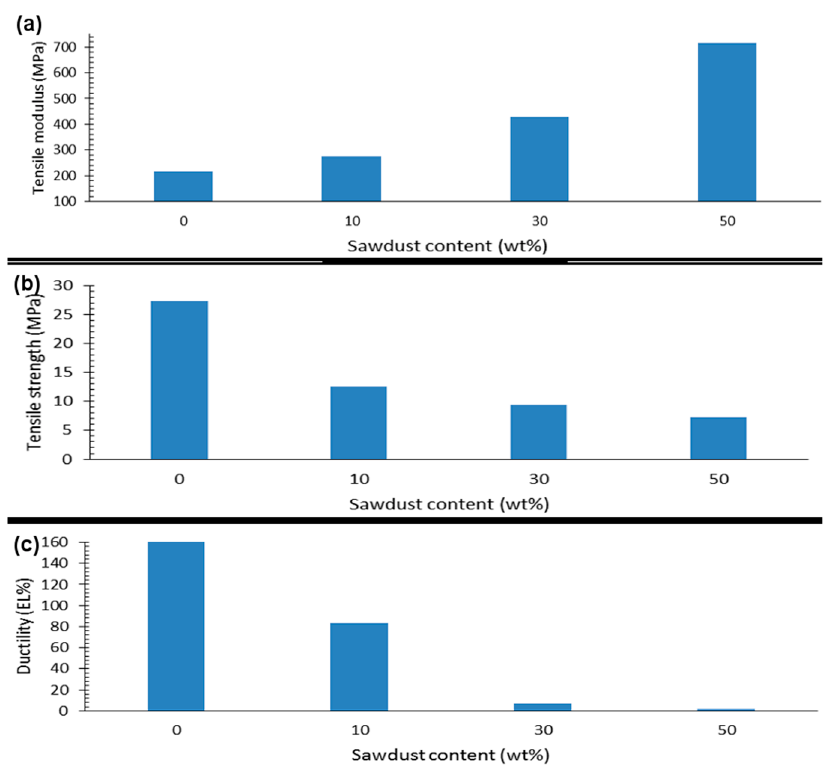
Figure 3. E ff ect of sawdust content on tensile properties of compression molded PCL-based films: Figure 3. Effect of sawdust content on tensile properties of compression molded PCL ‐ based films: ( a ) ( a ) tensile modulus (MPa), ( b ) tensile strength (MPa), and ( c ) ductility tensile modulus (MPa), ( b ) tensile strength (MPa), and ( c ) ductility (EL%).